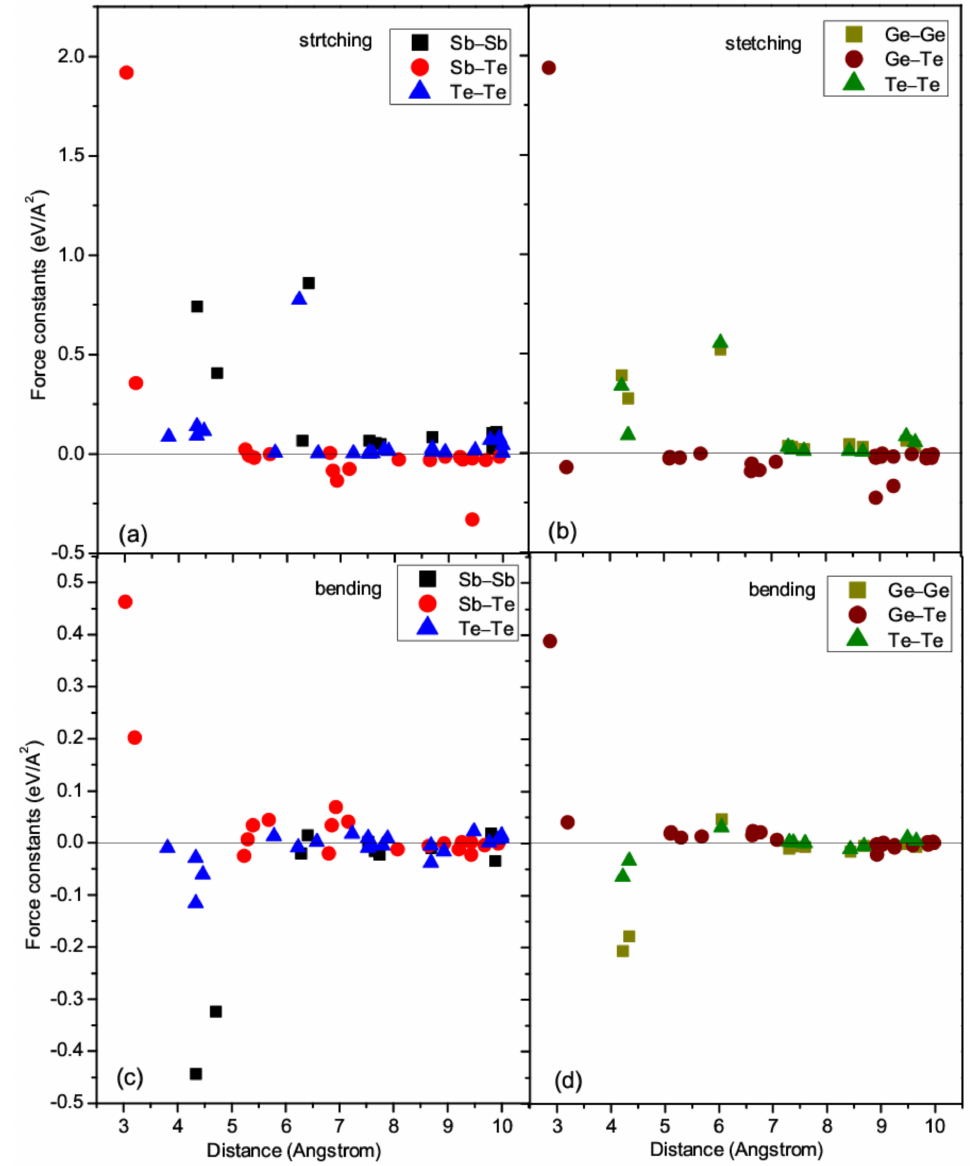
Figure 3. Stretching FCs of ( a ) Sb 2 Te 3 and ( b ) GeTe, and bending FCs of ( c ) Sb 2 Te 3 and ( d ) GeTe. The second interesting feature is that the bending FCs of the Ge-Ge and Sb-Sb bonds at the first and second NN distances between like atoms show large negative values, suggesting that the Ge-Ge and Sb-Sb bonds would be ready to move under slight shear perturbations, in accordance with their layer structure nature. It needs to be noted that negative FC between two atoms along a certain direction does not mean that the two atoms will leave, for the stability of a structure depends on the collective behavior of atomic vibrations [51,52]. As the phonon DOS shown in Figure 2a,b, all phonon modes are really positive, which means the two structures are dynamically stable. More details can be found from the separated bending FCs. In GeTe, the bending FCs of Ge-Ge bonds at a distance of 4.2170 Å are B1 = − 0.170 eV/Å 2 and B2 = − 0.242 eV/Å 2 , while these values become B1 = − 0.014 eV/Å 2 and B2 = − 0.342 eV/Å 2 at a distance of 4.3431 Å. The bending FCs of these slightly longer Ge-Ge bonds are rather asymmetric, suggesting that the shear deformation would be strongly direction-dependent. In Sb 2 Te 3 , the Se-Se bending FCs are B1 = − 0.309 eV/Å 2 and B2 = − 0.577 eV/Å 2 at a distance of 4.3447 Å, while